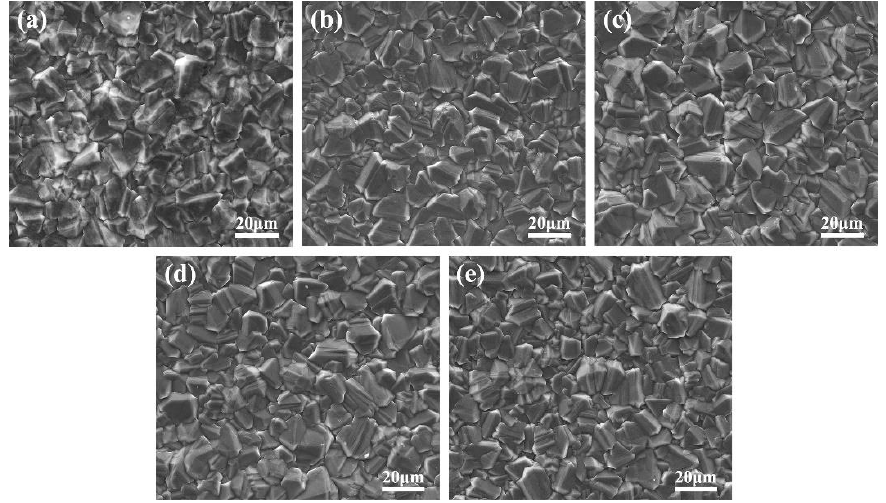
Figure 4. Surface morphology images of the different sample electrodes: ( a ) BDD, ( b ) TiO 2 /BDD, ( c ) TiO 2 /Au/BDD-30, ( d ) TiO 2 /Au/BDD-60, and ( e ) TiO 2 /Au/BDD-90.